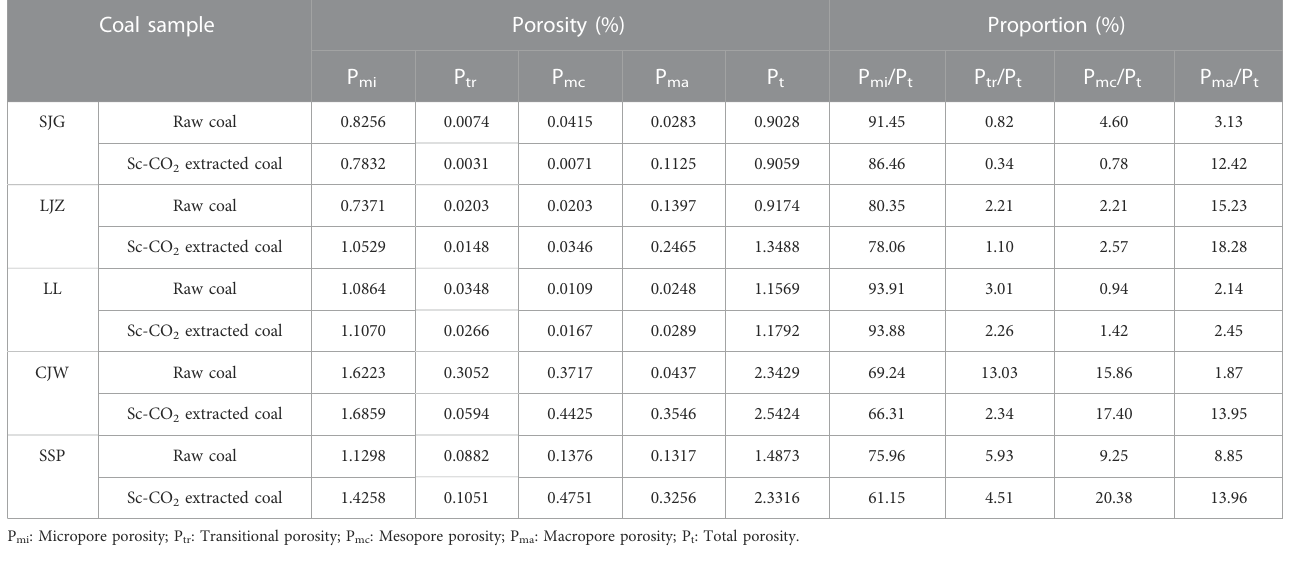
form small organic molecules in coal, which get fi lled in the pore structure of coal to form closed or semi-closed organic fi lling pores (Figure 11A). After Sc-CO 2 extraction, the small organic molecules present in the pore structure of fi lled coal are partially extracted, resulting in the increase of pore volume, speci fi c surface area, and porosity of coal to varying degrees. Owing to the short extraction time, some organic small molecules still do not get extracted completely (Figure 11B). At the same time, the pore throats originally fi lled with small organic molecules (Figure 11C) are likely to be opened from open pores (Figure 11D) after Sc-CO 2 extraction, and the porosity of coal pores becomes better.